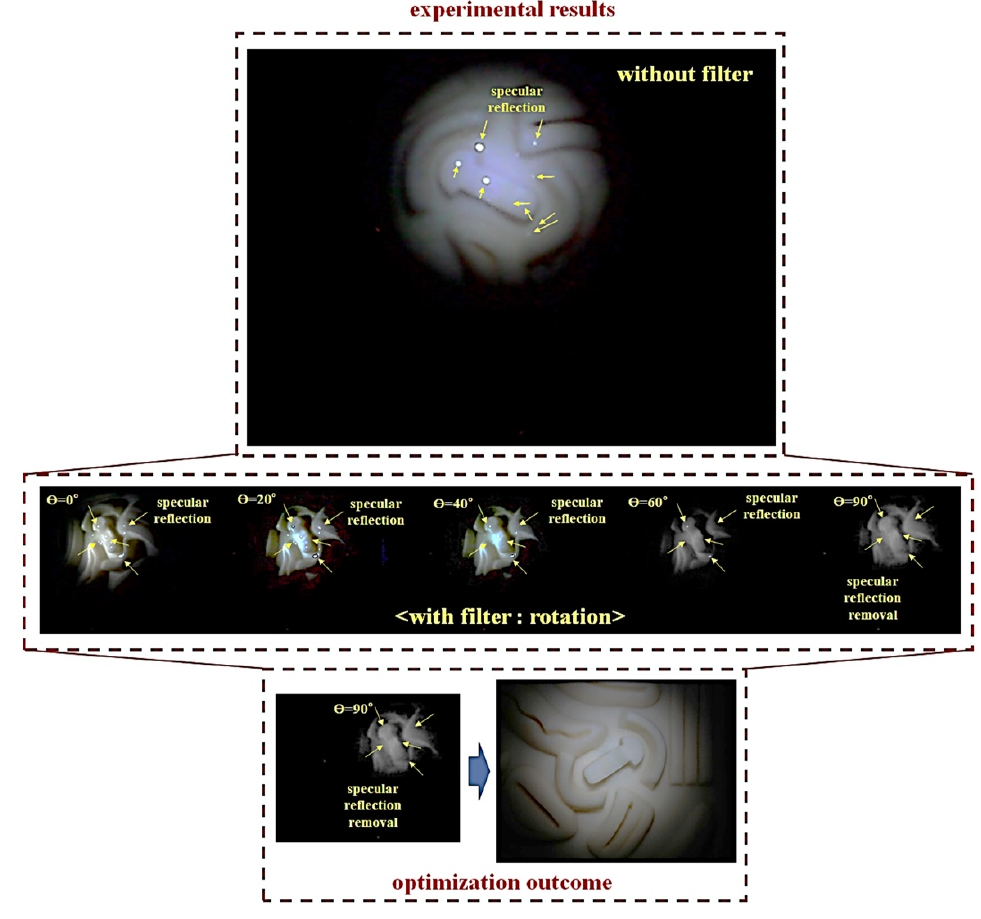
Figure 9. Phantom experiment result for removal specular reflection.